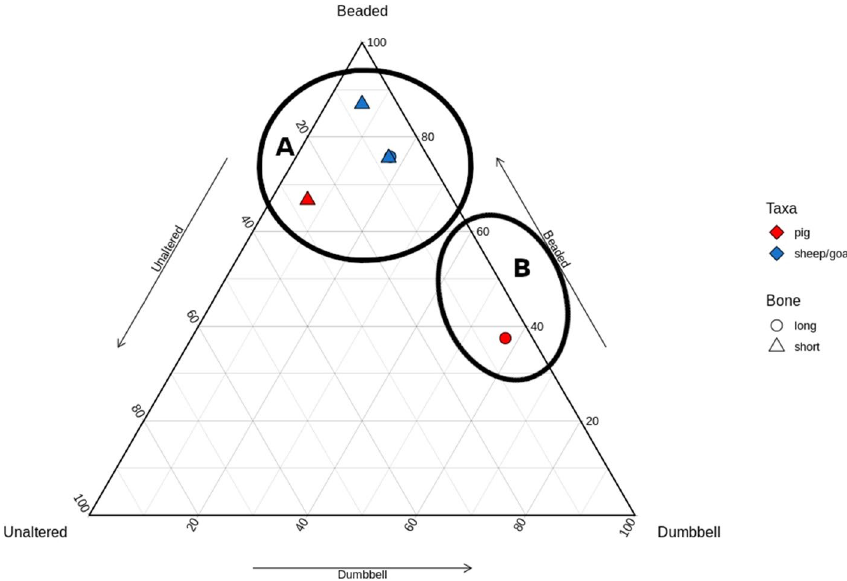
Figure 5. Ternary plot of Llanmaes samples; two natural groups are demarcated.